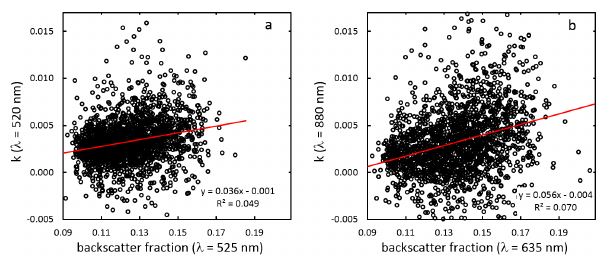
Figure 5. The compensation parameter ( k ) of individual filter spot changes calculated for (a) green ( λ = 520nm) and (b) near-infrared ( λ = 880nm) light as a function of filter-spot-averaged backscatter fraction at the nearest nephelometer wavelengths λ = 525nm and λ =